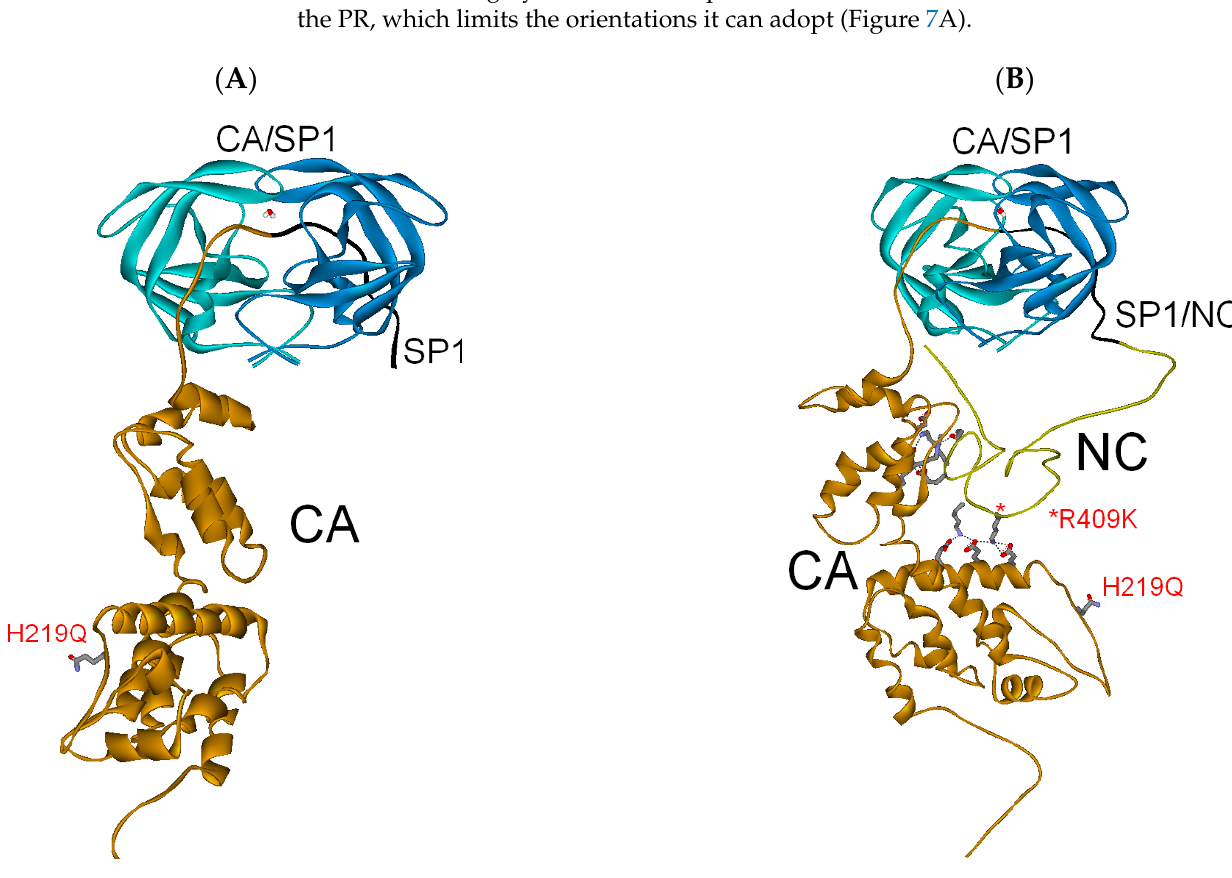
Figure 7. ( A ) HIV-1 PR (front view) bound to CA/SP1 cleavage site in CA-SP1 protein, PR backbone as ribbon A-subunit teal, B-subunit blue), CA-SP1 protein backbone ribbon (CA bronze, SP1 black), CA/SP1 cleavage site indicated. Gag non-cleavage site PI resistance residue CA H219Q shown (red label), tetrahedrally coordinated active site water indicated; ( B ) PR bound to the CA/SP1 cleavage site in the non-native CA-SP1-NC polyprotein, PR as in ( A ), CA-SP1-NC polyprotein backbone as ribbon (CA bronze, SP1 black, NC yellow) with a substrate-clamp between the CA and NC subdomains in which the Gag non-cleavage site PI resistance mutation R409K (red label) coordinated the identical H-bond network as described for the substrate-clamp in the full-length Gag polyprotein with the R409K mutation (Figure 3B), cleavage sites shown. Tetrahedrally coordinated active site water and substrate-clamp residues shown (carbon grey, oxygen red, nitrogen blue). H-bonds shown as dashed black lines. See Results and Discussion Section 3.2.1. for PR bound to full-length Gag with R409K mediated substrate-clamp for detailed description of H-bond